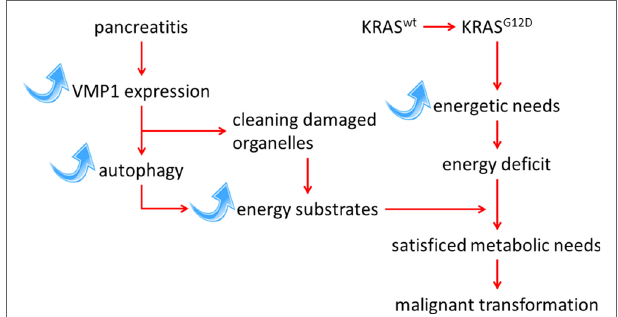
FigURe 1 | Schematic representation of the interaction between KRAS -mediated transformation in PDAC and autophagy induced by the pancreatitis-associated protein vMP1 pathways